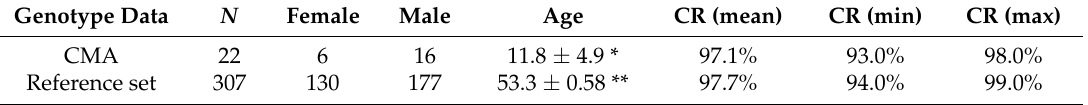
Table 1. Characteristics cow’s milk allergic children (CMA) and the reference